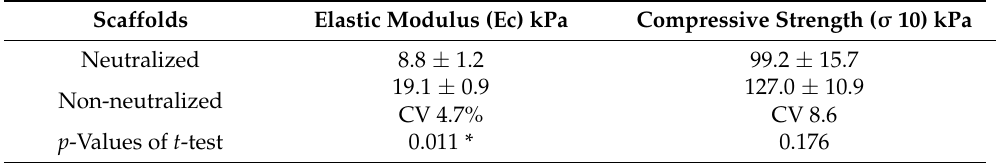
Table 3. Scaffolds’ mechanical properties under